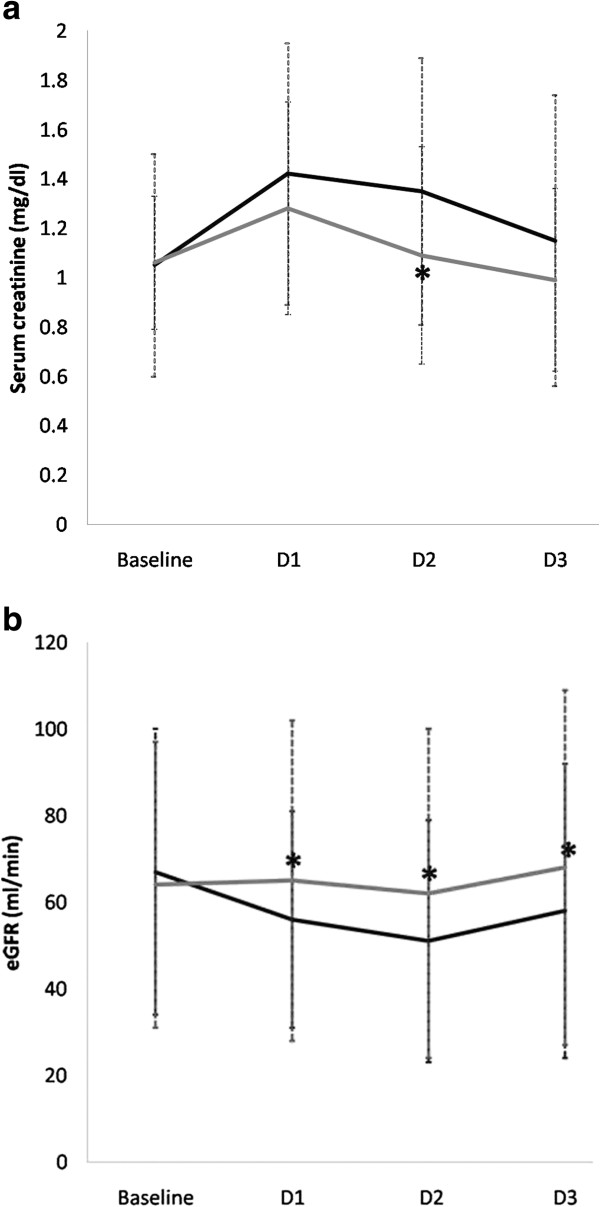
Mean changes of SCr (2A) and eGFR (2B) at day 1 (D1), day 2 (D2), and day 3 (D3) after operation compared with baseline in patients randomized to placebo (black line) or rHuEPO (gray line). *p < 0.05 compared between the placebo and rHuEPO group.